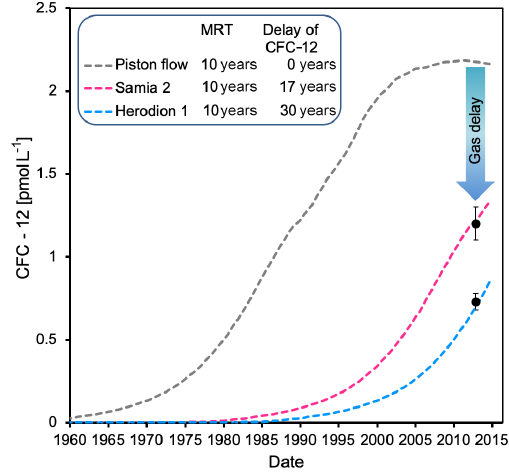
Figure 5. In a CFC-12 vs. time plot, a piston flow model with an MRT of 10 years obtained from the water-bound tracer tritium and 36 Cl / Cl fits the CFC-12 measurements with a gas delay of 17 years for Samia 2 and 30 years for Herodion